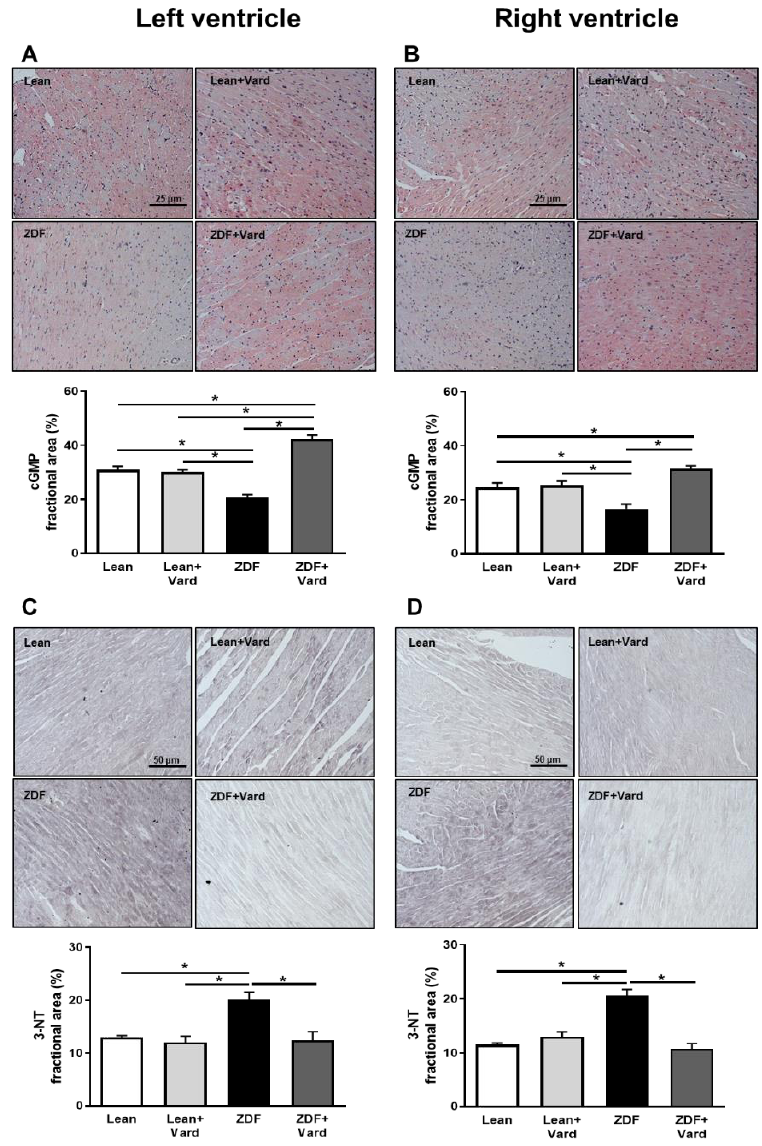
Figure 1. PDE-5A inhibition affected cGMP and 3-NT levels in the left and right ventricles of ZDF hearts. Representative immunohistochemical images of myocardial cGMP (( A , B ), magnification: 400 × ) and 3-NT (( C , D ), magnification: 200 × ) generation in LV ( A , C ) and RV ( B , D ) tissue sections for all experimental groups. Bar graphs show the results of quantitative evaluations for the cGMP assays ( LV Lean, 31 ± 1.3%; LV Lean + Vard, 30. ± 0.8%; LV ZDF, 20.8 ± 1%; LV ZDF + Vard, 42.3 ± 1.4%; RV Lean, 24.6 ± 1.6%; RV Lean + Vard, 25.3 ± 1.5%; RV ZDF, 16.7 ± 1.7%; RV ZDF + Vard, 31.6 ± 1%; A , B bottom panels) and 3-NT assays ( LV Lean, 13 ± 0.3%; LV Lean + Vard, 12 ± 1.2%; LV ZDF, 20.1 ± 1.4; LV ZDF + Vard, 12.4 ± 1.6%; RV Lean, 11.5 ± 0.3%; RV Lean + Vard, 12.9 ± 0.9%; RV ZDF, 20.7 ± 1.1%; RV ZDF + Vard, 10.8 ± 0.9%; C , D bottom panels). Values denote fractional areas (%) for all experimental groups. The number ( n ) of rat hearts involved were: Lean, 6 – 8; Lean + Vard, 4 – 7; ZDF, 6 – 8 and ZDF + Vard, 6 – 8. Data are given as mean ± SEM, * p < 0.05. cGMP: cyclic guanosine monophosphate; 3-NT: 3-nitrotyrosine.